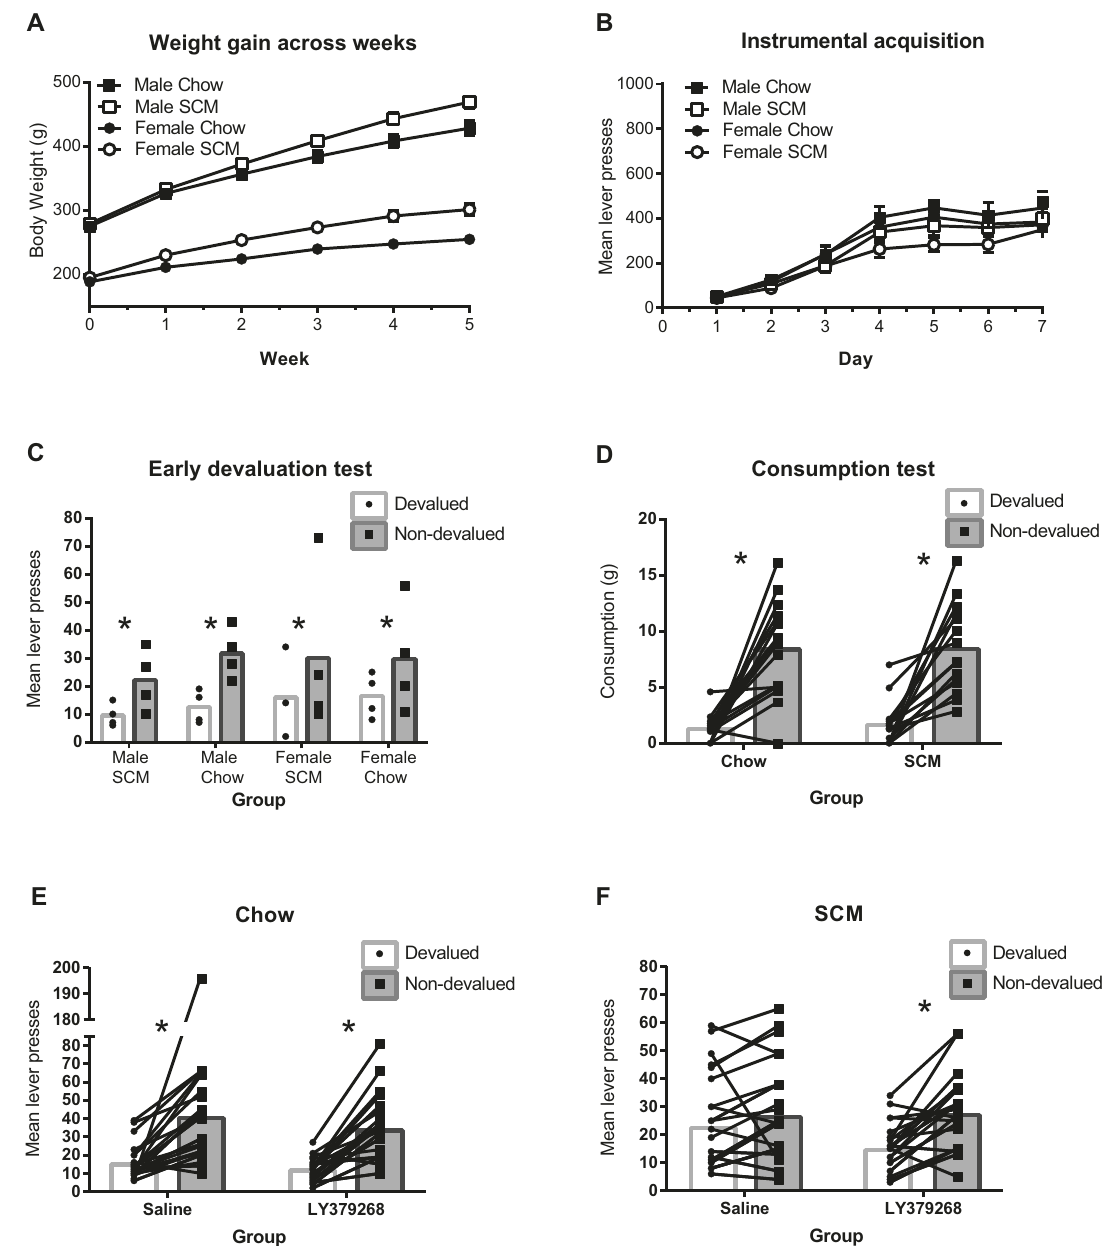
Fig. 2 Long-term access to an obesogenic diet reduces sensitivity to outcome devaluation and sensitivity is restored by mGluR2/3 agonism. A Weight gain. Mean (SEM) weight gain across weeks of the diet treatment. All rats gained weight across fi ve weeks of a SCM or Chow diet. Rats in the SCM groups gained more than those receiving only chow and males gained more than females. B Instrumental acquisition. Mean (SEM) lever presses across days of instrumental training. All animals increased lever-pressing across days of training. C Early devaluation test. An early outcome devaluation test showed no difference in sensitivity to devaluation between groups receiving Chow or SCM diets nor between males and females. D Consumption test of outcome devaluation. All animals showed sensitivity to outcome devaluation when measured as consumption of the prefed (devalued) versus alternative (nondevalued) food. E Outcome-devaluation test: Chow group. Rats maintained on a chow diet are sensitive to outcome devaluation. Responding overall was attenuated following administration of LY268379 (1 mg/kg) but sensitivity to devaluation was robust in both drug conditions. F Outcome-devaluation test: SCM group. A history of access to an obesogenic diet reduces sensitivity to outcome devaluation. This de fi cit was ameliorated by systemic mGluR2/ 3 agonism with LY379268 (1 mg/kg). N = 26 for the Chow and 27 for the SCM groups, respectively. Across all fi gures, * indicate that p < 0.05. Outcome-devaluation tests . An early test was conducted drug free in rats the lever was available, but no outcomes were delivered. After this test, from the fi rst cohort only. Rats in each diet condition were assigned to rats in the fi rst cohort received further training (see above) before being either devalued or nondevalued conditions in an attempt to match tested again as follows. response rates from training. Rats had free access to either the previously Rats within each diet condition were assigned to drug groups in a earned outcome (devalued condition) or alternative food (nondevalued counter-balanced manner based on lever pressing rates during the last condition) for 1 h in a previously exposed individual cage after which they training session. Rats had free access to either the previously earned were transferred to the operant chamber for a 5-min extinction test where outcome (devalued) or the alternative food (nondevalued). Following an Translational Psychiatry (2022)